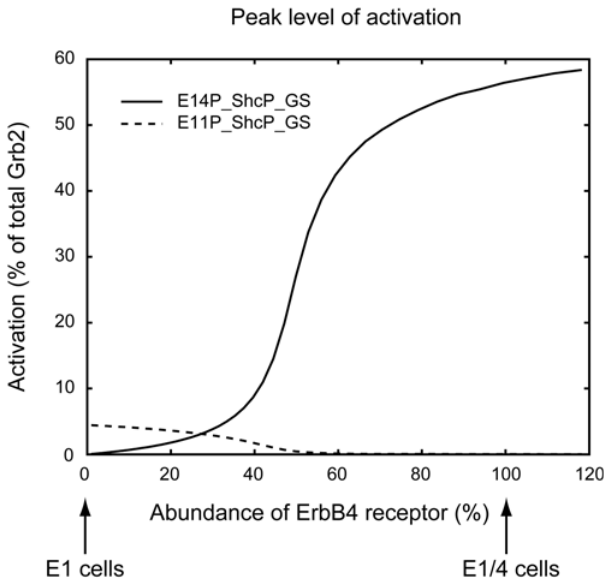
Figure 8. Effect of ErbB4 receptor concentration on E11P_ShcP_GS and E14P_ShcP_GS. The two complexes E11P_ShcP_GS and E14P_ShcP_GS in Figure 6 regulate Ras activity. The solid and dashed lines represent the change in peak activity (%) of E14P_ShcP_GS and E11P_ShcP_GS, respectively, following 10 nM EGF treatment and depending on the concentration of ErbB4 receptors in the detailed upstream model, respectively. The 0% ErbB4 receptor concentration (E4=0) is regarded as representing E1 cells, while the 100% level (E4=1.0) represents E1/4 cells.